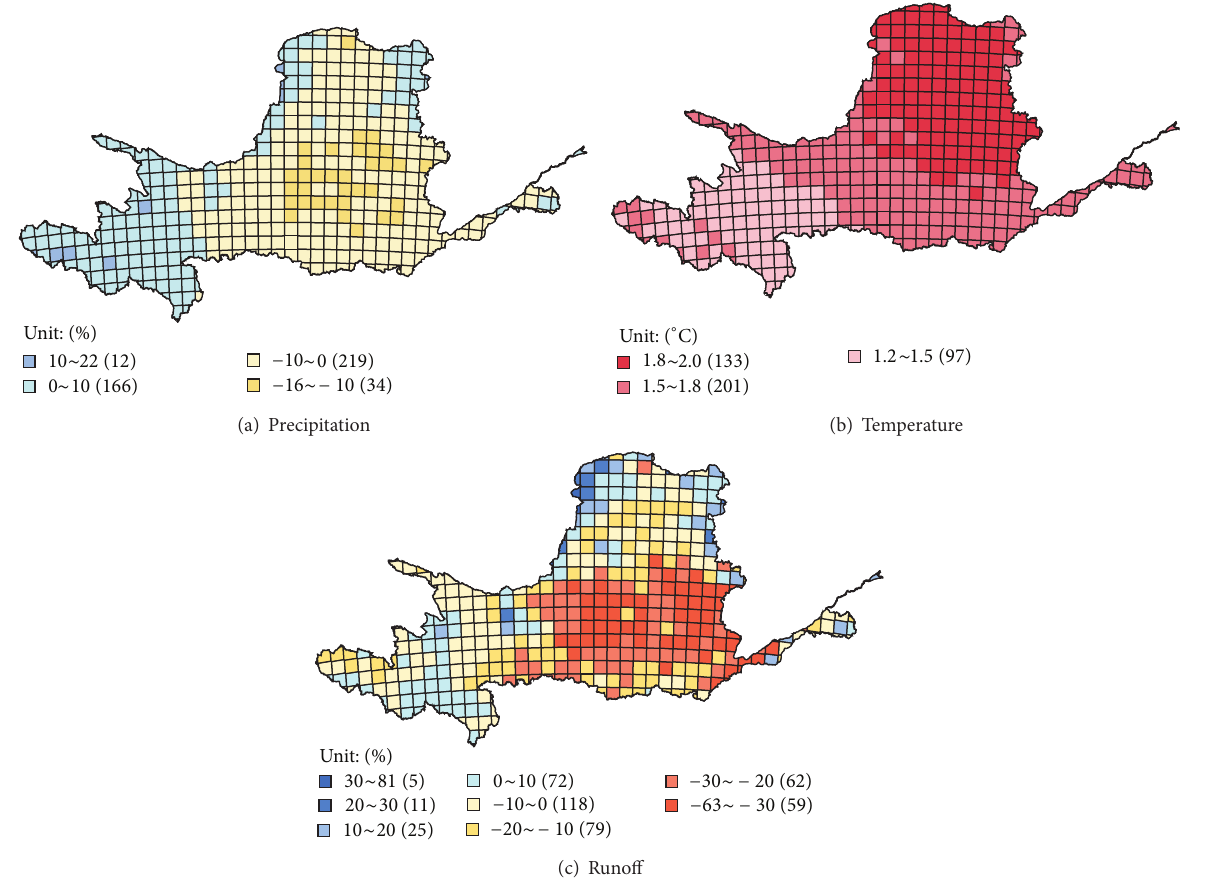
Figure 5: Changes in (a) mean annual precipitation, (b) mean annual temperature, and (c) mean annual runoff from the bias-corrected RegCM3 compared to that simulated by the baseline period (1971–2000) in the